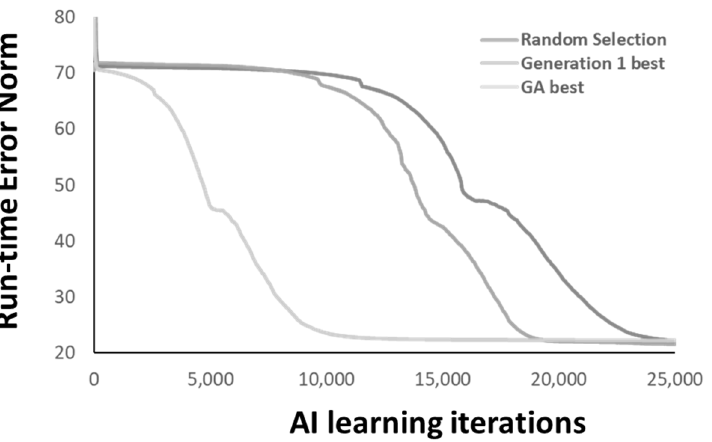
Figure 13. The contribution of GA optimization.